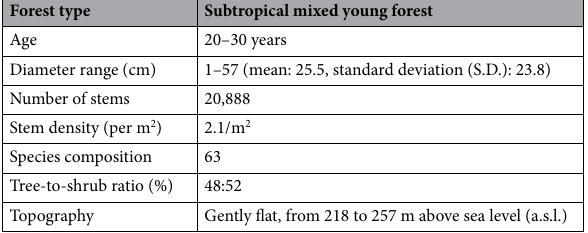
Table 2. The forest condition and descriptive statistics.